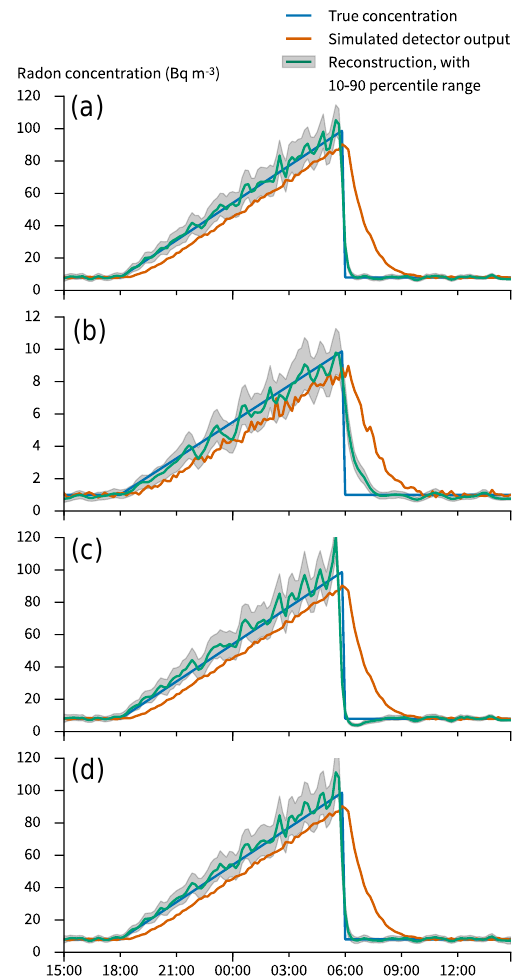
Figure 6. Tests of Bayesian Monte-Carlo deconvolution based on a simulation of the detector with known radon time series. Panel (a) shows a simulation with high radon concentrations, representative of an inland site on a stable night. In (b) , the peak concentration is a factor of 10 lower. Panel (c) shows the effect of an incorrect prior, where the external flow rate was too low by a factor of two. Panel (d) has the same configuration as (c) , but the sampler has run for ten times longer, 60 × 10 3